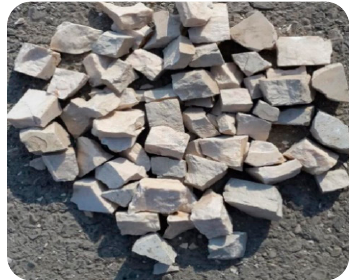
Figure 5. Recycled coarse aggregate (RCA).